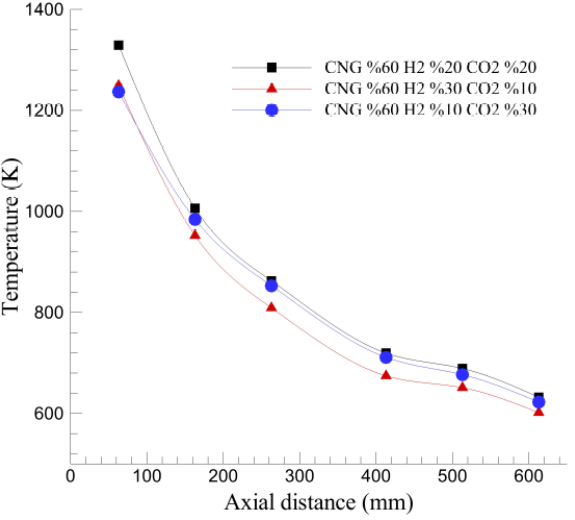
Figure 7: Axial temperature distributions (Swirl number: 0.4, Equiva- lence ratio: 0.9).